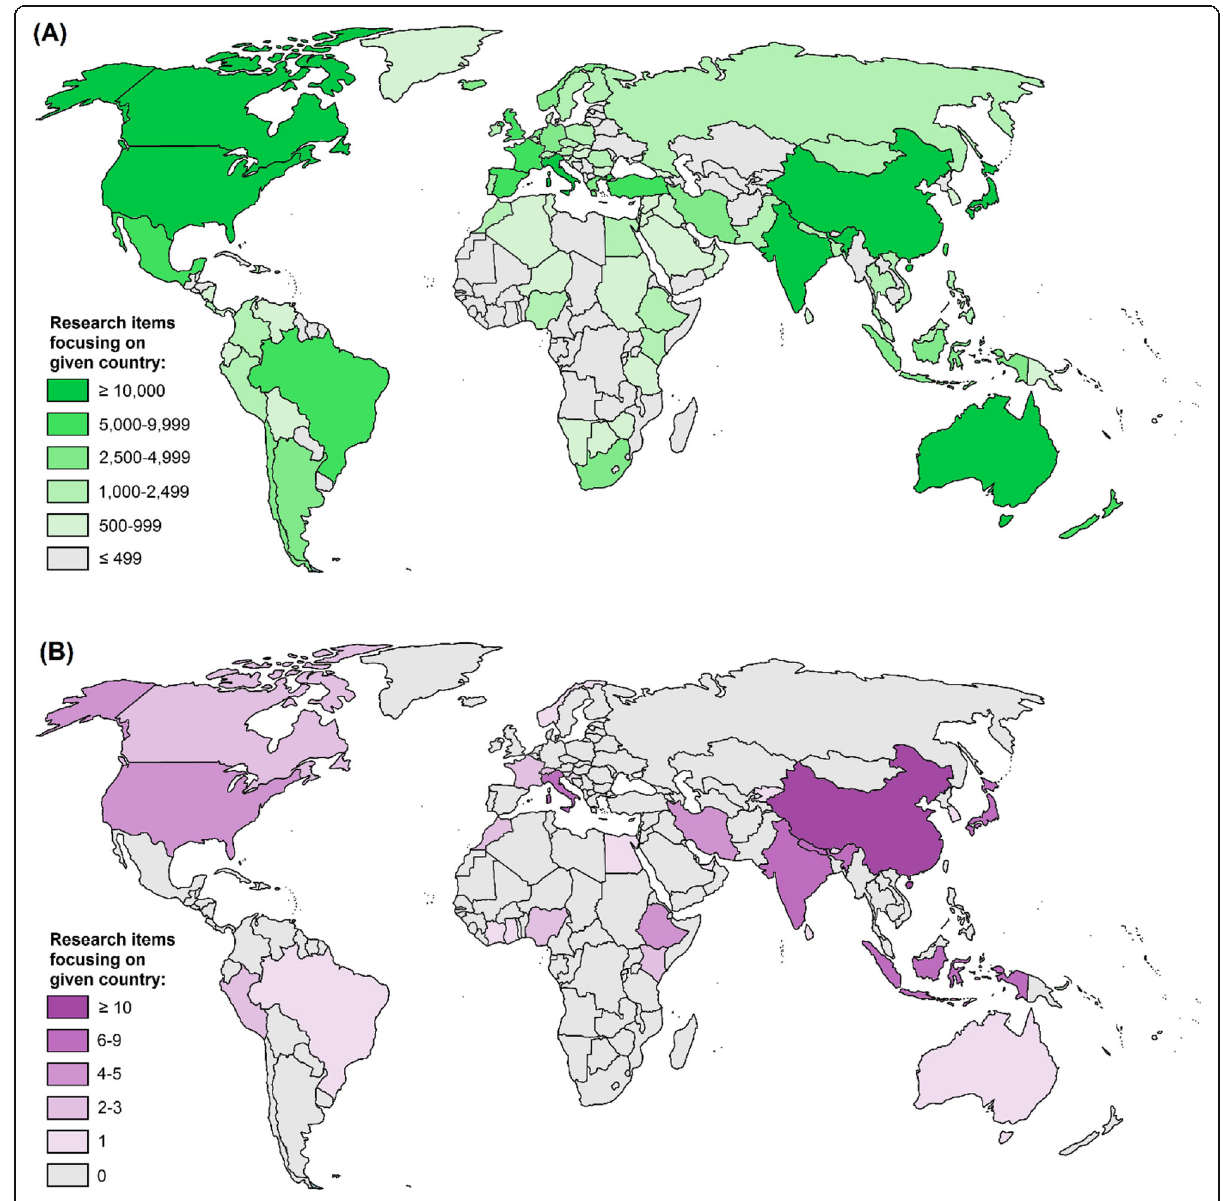
Fig. 2 A comparison between geographical focus of WOS-indexed papers on natural hazards adopted form Emmer (2018 (part ( a )); and geographical focus of papers published in Geoenvironmental Disasters (part ( b